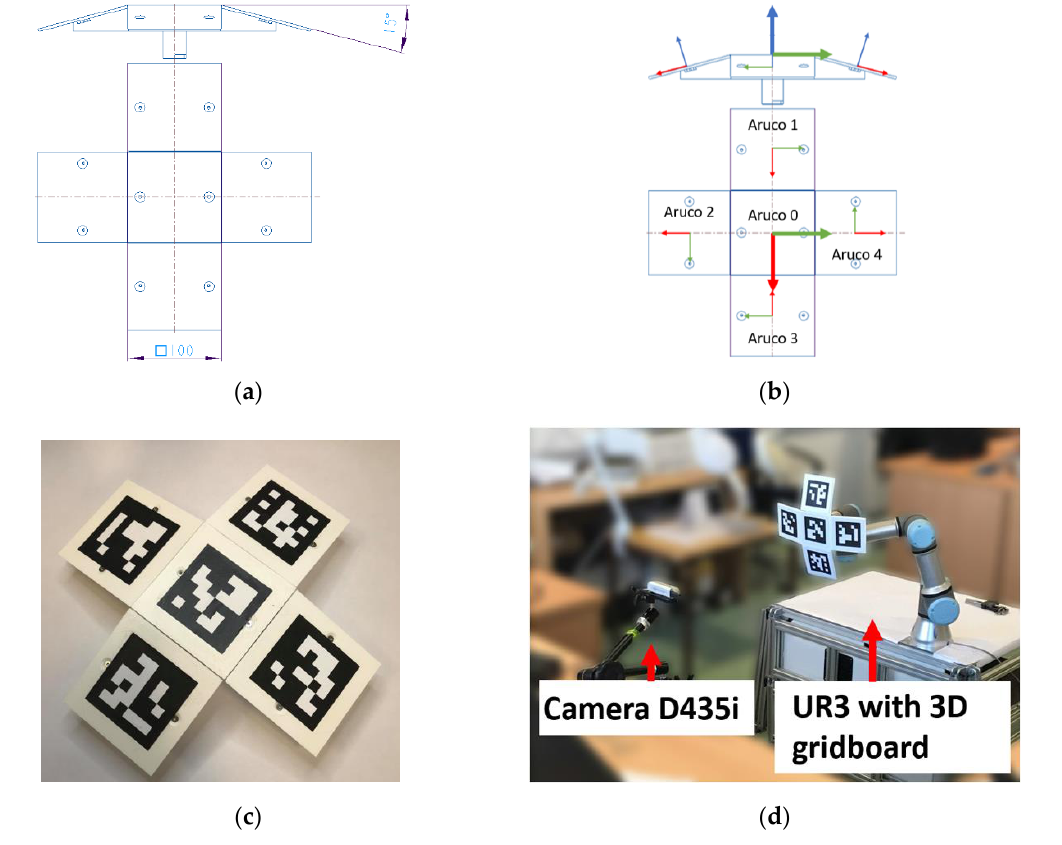
Figure 10. Three-dimensional grid board: ( a ) schema; ( b ) position and orientation of individual tag on the 3D grid board; ( c ) the real 3D grid board; ( d ) the UR3 robot with the 3D grid board. Table 5. Three-dimensional grid board